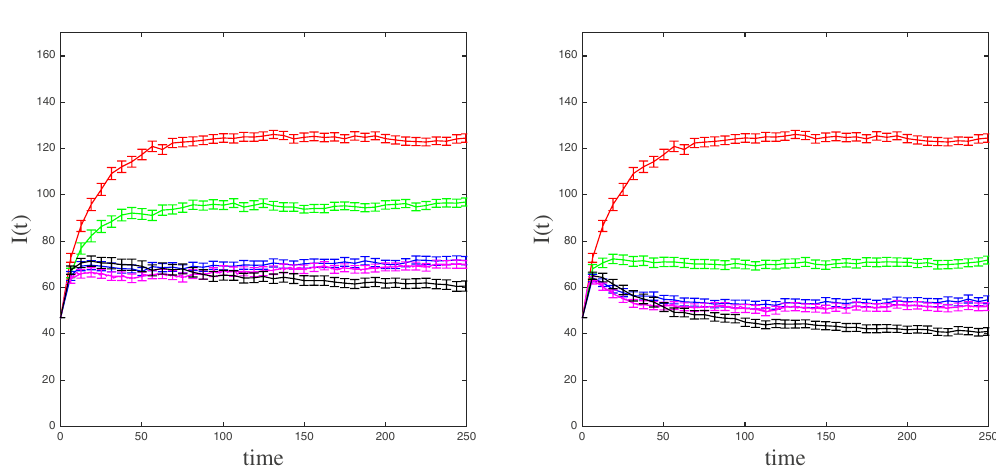
Figure 7. The mean number of infected individuals (and 95% confidence intervals) in the homogeneously weighted contact network as a function of time (days) for three selection strategies of 14 (left panel) and 30 (right panel) most central nodes whose infection status it is used to alert the community: SPN (red), Rand (green), DC (blue), and EC (black).